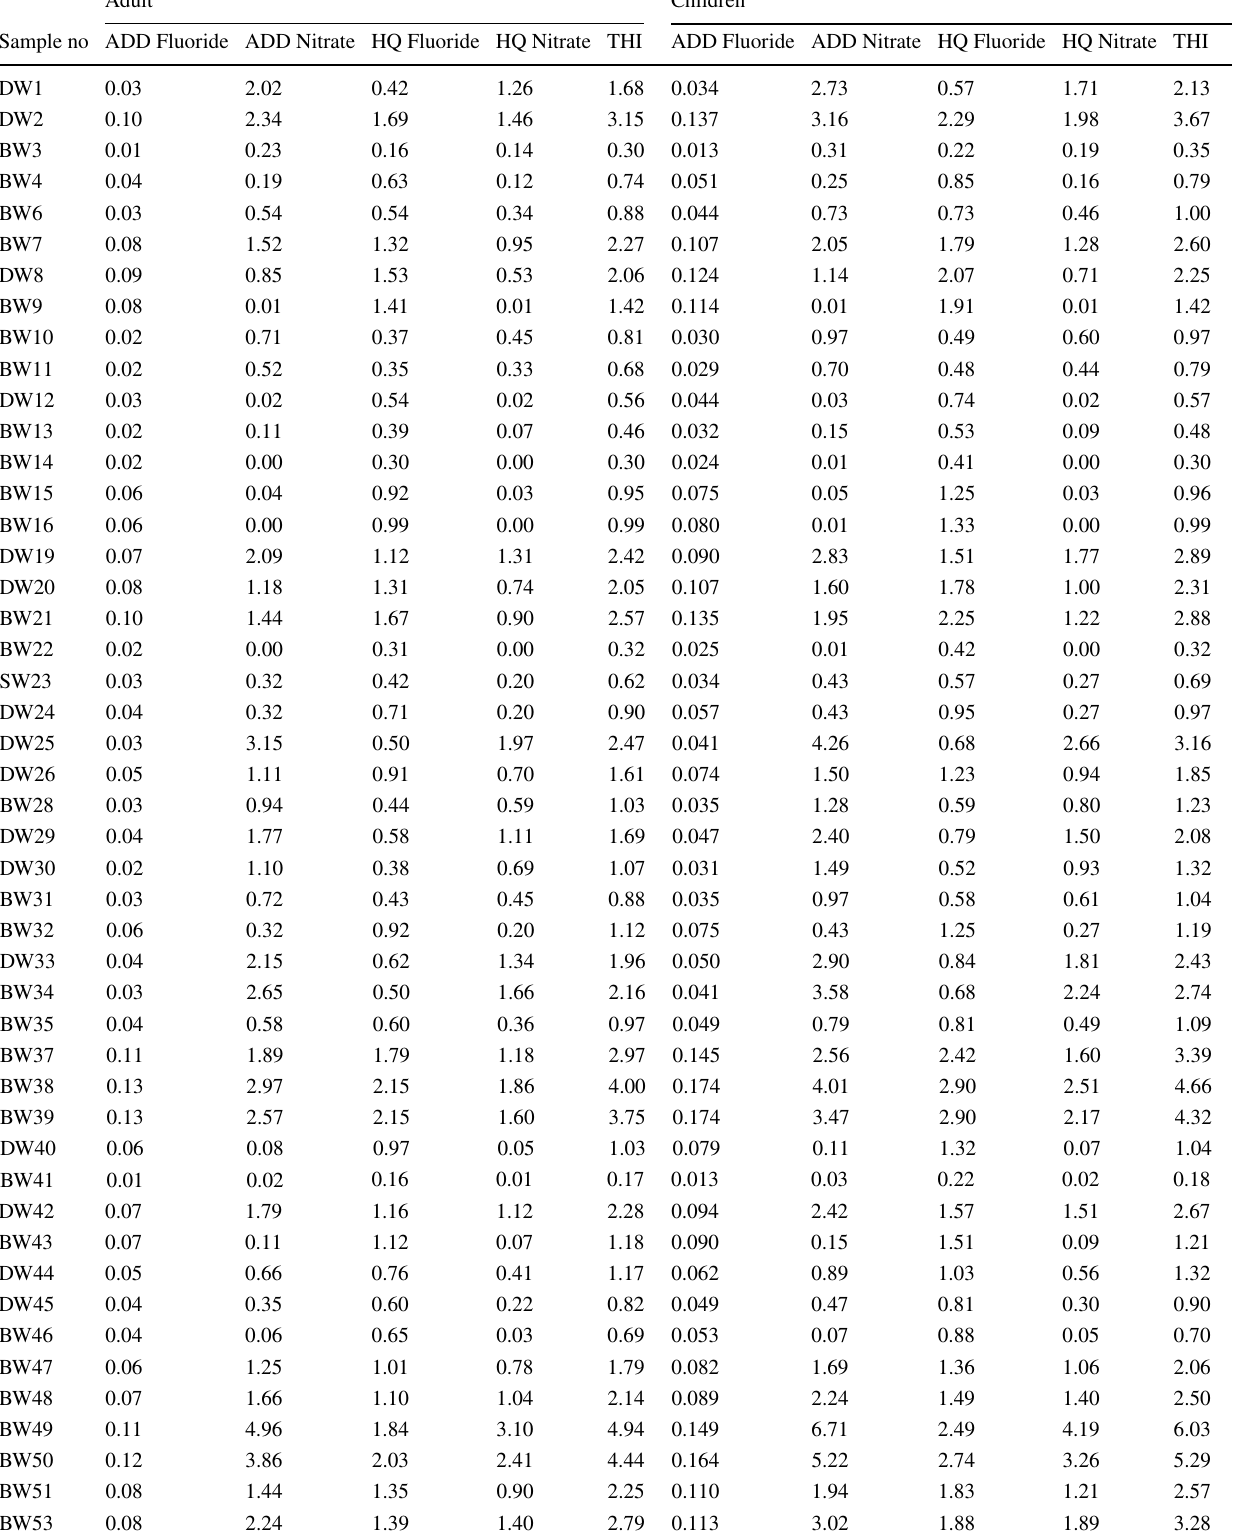
Table 2 Average daily dose (ADD) hazard quotient (HQ) and total hazard index (THI) for adults and children in the study area for post-monsoon season Adult